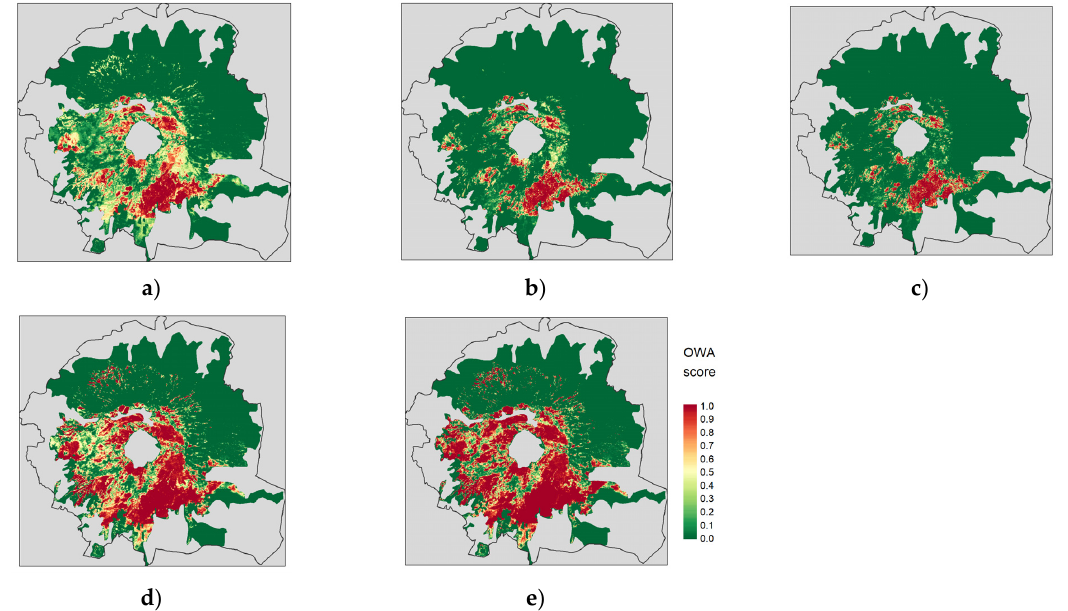
Figure 7. Global evidence of burn shown by OWA score [0, 1] (left column) over the Vesuvius study site: OWA AND ( a ), OWA almostAND ( b ), OWA Average ( c ), OWA AlmostOR ( d ) and OWA OR ( e ); borders of Vesuvius National Park are highlighted in black and masked areas in gray.